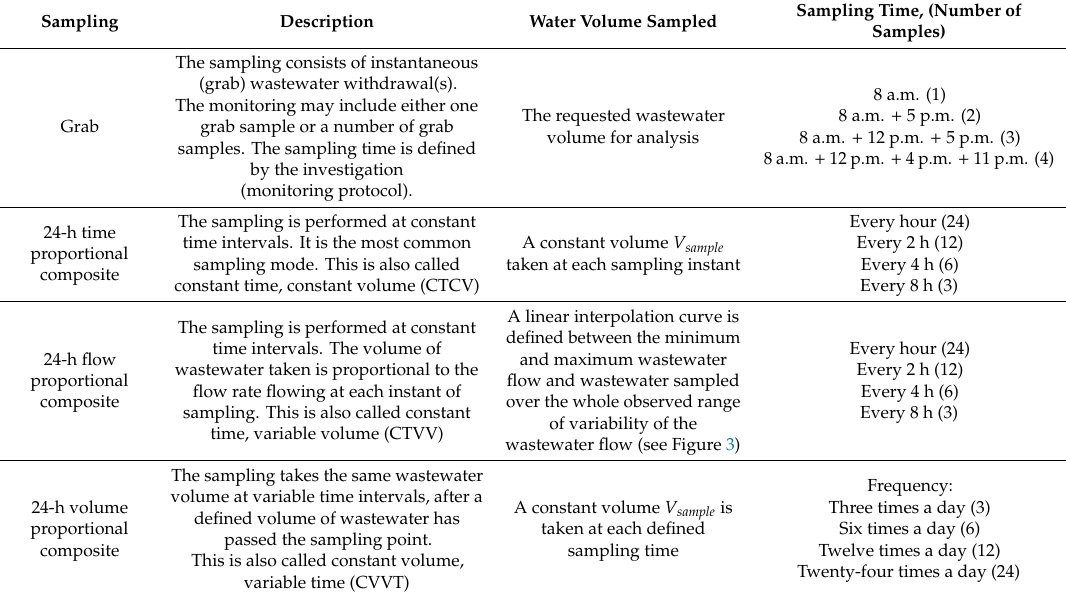
Table 1. Description of the sampling modes adopted and compared in this study for average concentrations of the di ff erent compound.